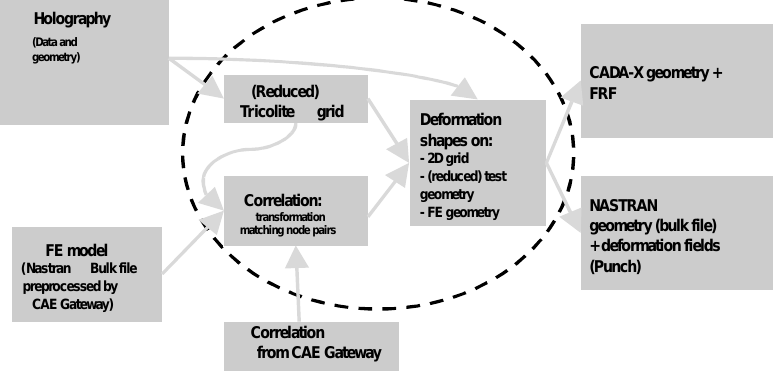
Fig. 3. HoloModal CAE Integration.